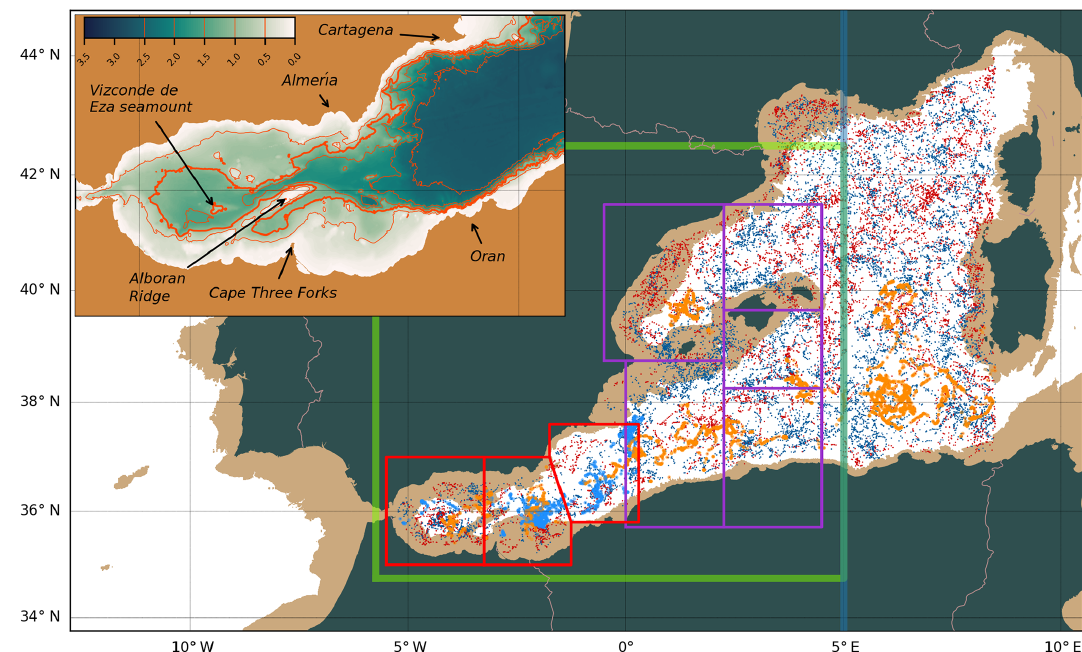
Figure 1. Map of the western Mediterranean study region. Cyclonic and anticyclonic eddy tracks from gridded altimetry are plotted in blue and red, respectively, for the 2013–2016 period; tracks with lifetimes greater than 1 year are highlighted in light blue and orange. Brown shading indicates bathymetry shallower than 1000m. The green box shows the domain used for the eddy property analysis in Sect. 4.1. The blue line marks the eastern boundary of the IBI model domain. The box areas bounded in red in the Alboran Sea indicate the three subregional domains used for eddy compositing in Sect. 4.2. Bounded areas in purple show five additional subregions for which composites are shown in Figs. S5–S17. The inset map provides further details of the topography and relevant physical features of the Alboran Sea and